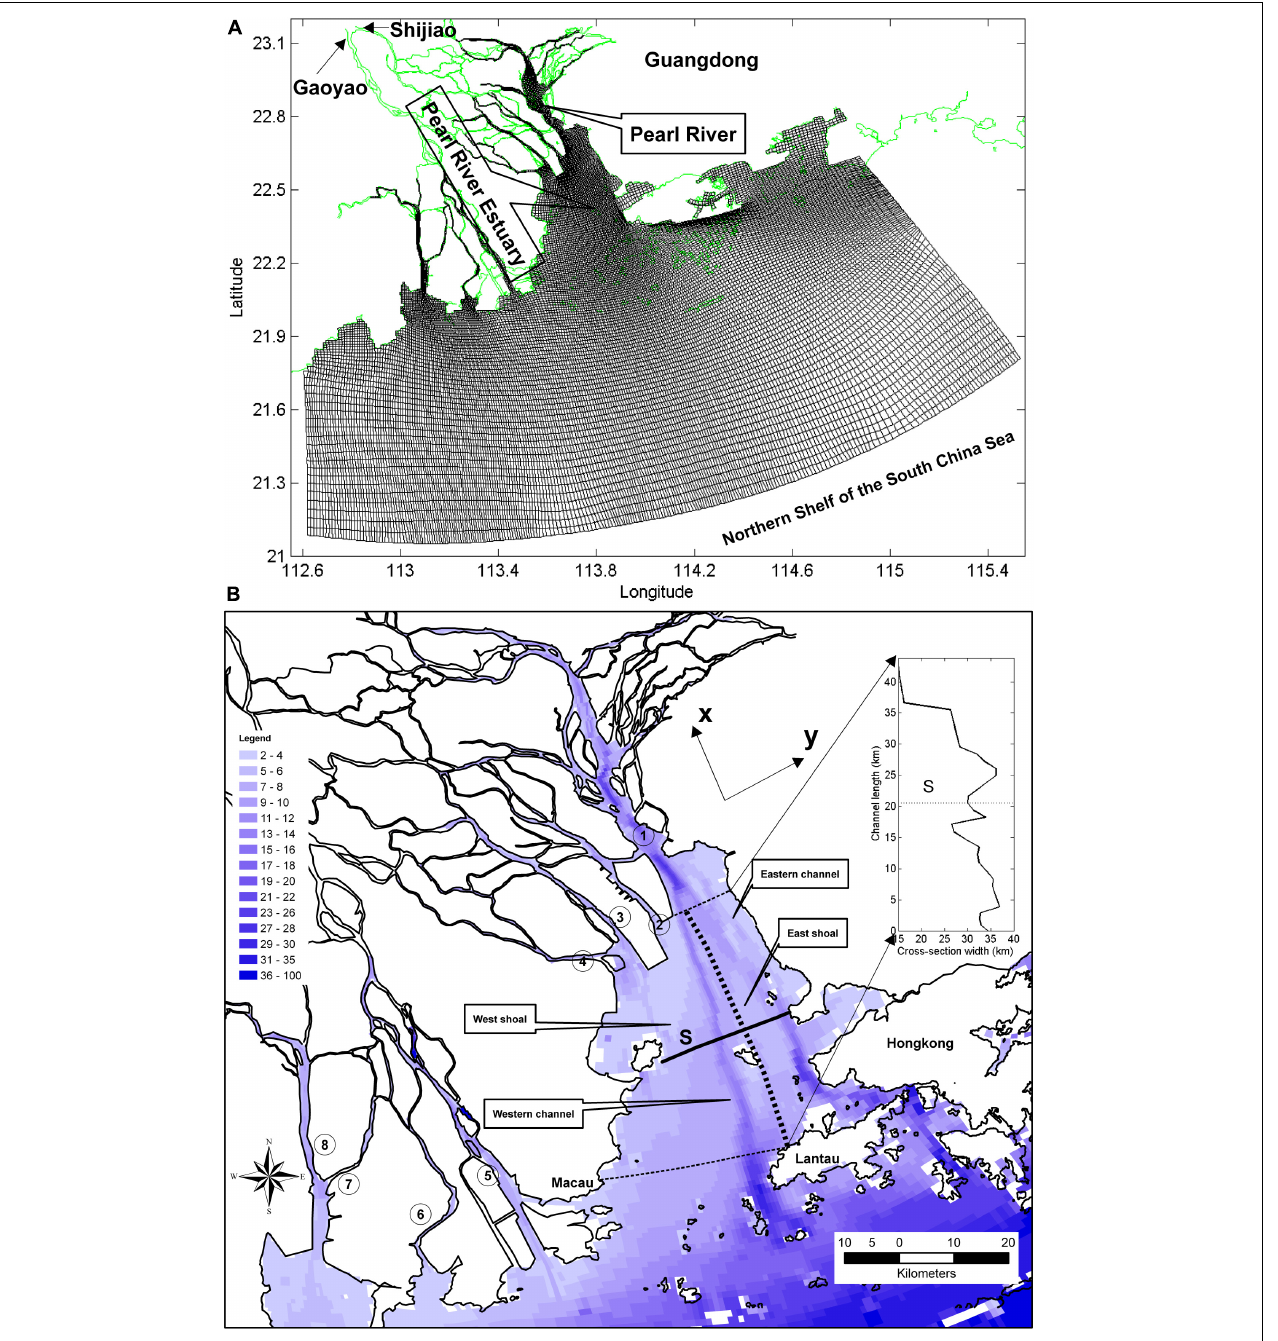
FIGURE 1 | (A) Model grids (black line). Green line represents the coastal line at the Pearl River Estuary (PRE) and its adjacent coastal region. Gaoyao and Shijiao are the two river flow gauge stations. (B) Bathymetry at the model region. Black line represents the coastal line at the PRE. The numbers in circles represent the mouths of the eight inlets in the PRE, (cid:172) : Humen, (cid:173) : Jiaomen, (cid:174) : Hongqimen, (cid:175) : Henmen, (cid:176) : Modaomen, (cid:177) : Jitimen, (cid:178) : Hutiaomen, and (cid:179) : Yamen. Solid lines are model sample cross-channel section S at the middle PRE. Thick dashed line represents the boundary between the western channel and eastern channel of the PRE. Thick dashed lines represent south and north boundaries of the target area in this study. The inserted image in panel (B) represents the variation of channel width (black line) from south (0 km) to north (44 km) of the target area. The dashed lines in the inserted image represent the locations of cross-channel section S. The x–y arrow in the panel (B) represents the coordinates in this study, the x-coordinate indicates the along-channel direction and points from south to north, and the y-coordinate indicates the cross-channel direction and points from west to east.